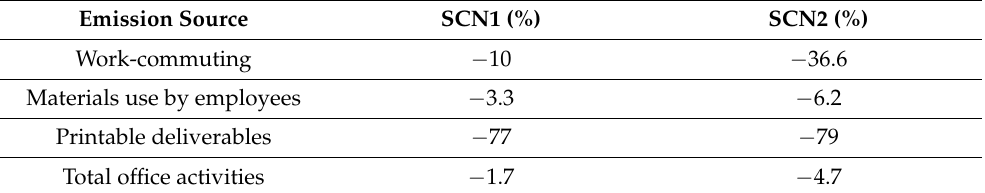
Table 6. Percentage differences (%) in CF of each emissions source between the base case and the mitigation scenarios related to office activities and employees for reducing the CF of the research